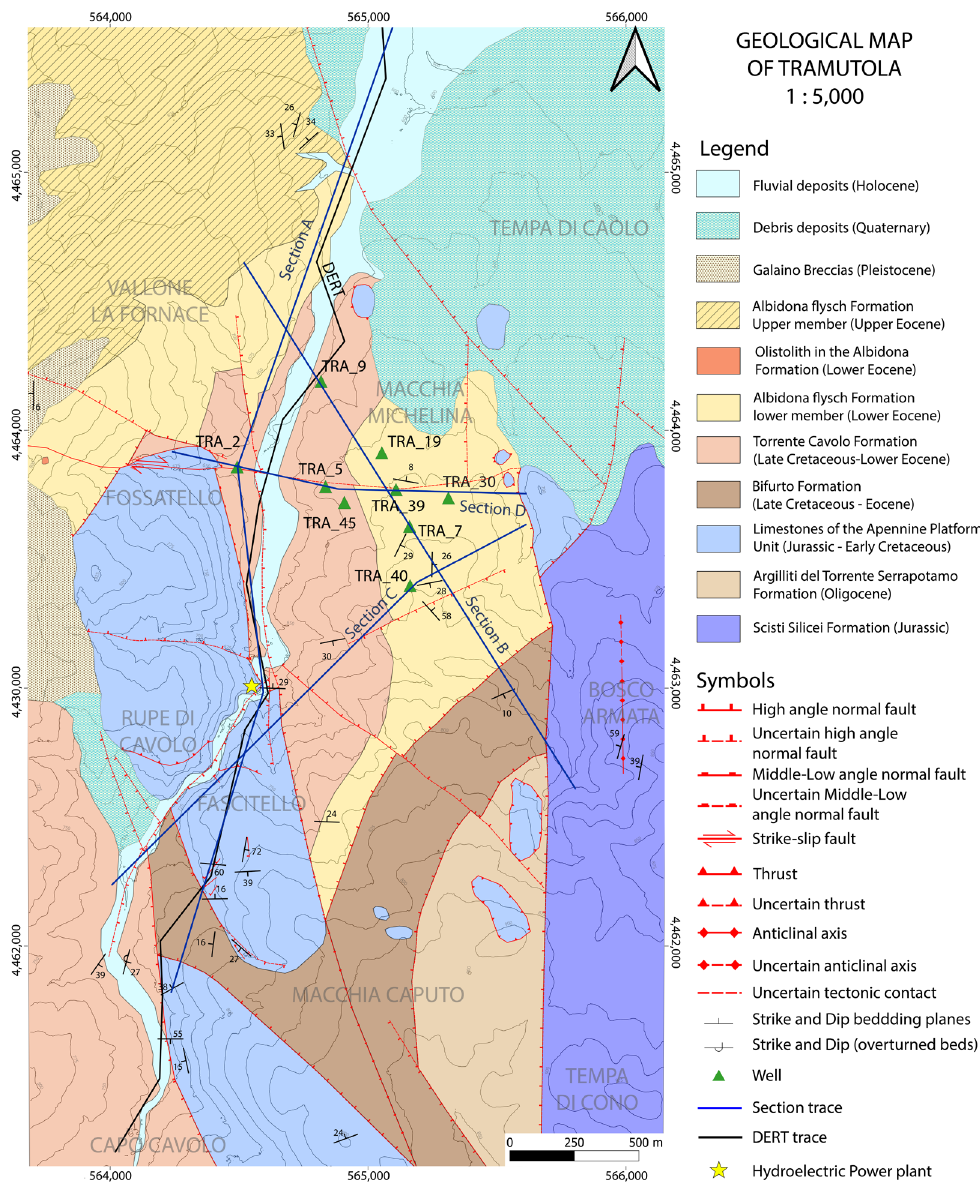
Figure 5. Geological map of the study area.